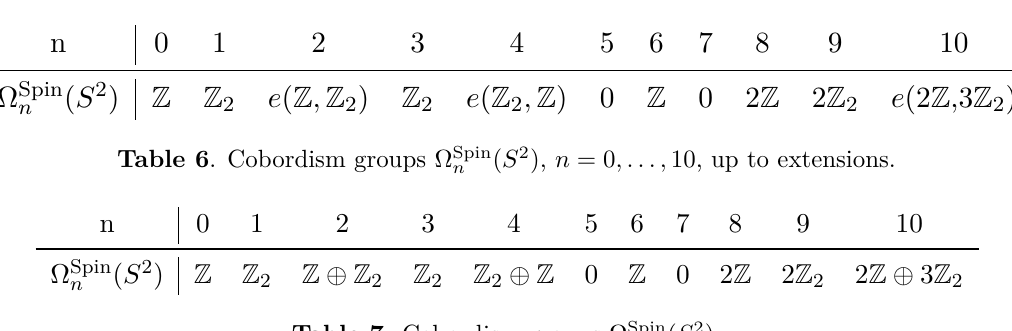
Table 7 . Cobordism groups Ω Spin